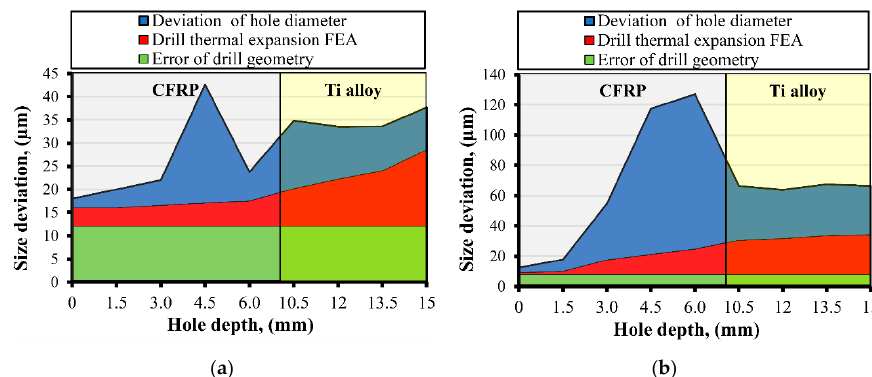
Figure 7. Hole diameter measured in hole No. 1. ( a ) Components of hole diameter deviation for hole No. 1 trail No. 2 ( v (15); f (0.05); T d (120)); ( b ) components of hole diameter deviation for hole No. 1 trail No. 7 ( v (65); f (0.02); T d (5)).